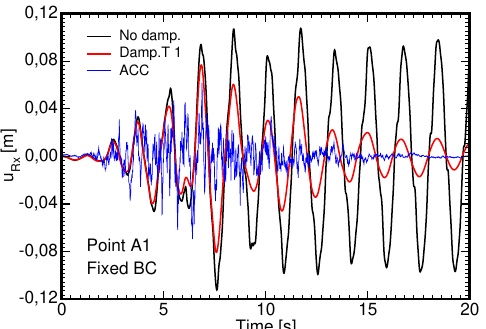
Figure 6. Time variation of horizontal displacement u Rx monitored at Point A1. Blue line is the scaled variation of the prescribed acceleration.